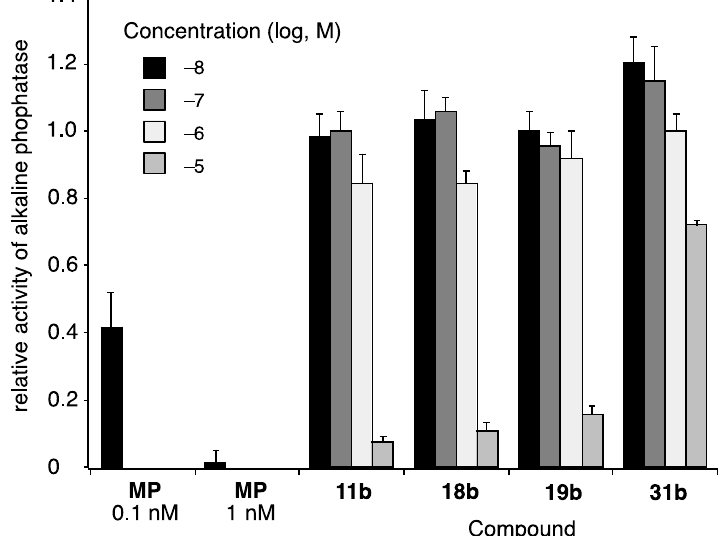
Figure 7. PR-antagonistic activities of selected coumarinamide derivatives, evaluated by means of alkaline phosphatase (AP) assay using T-47D cells. The vertical axis is the activity of alkaline phosphatase in the presence of 1 nM progesterone and test compound, normalized to progesterone alone as 1. MP: mifepristone (PR antagonist).